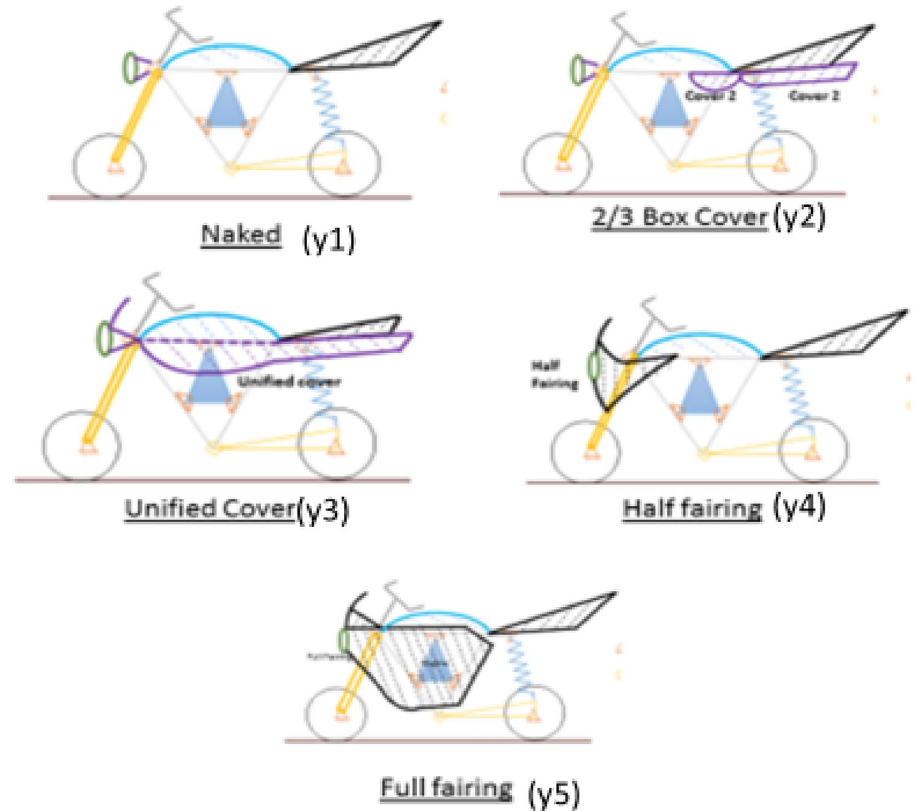
Figure 6. Classification of two-wheelers based on visual